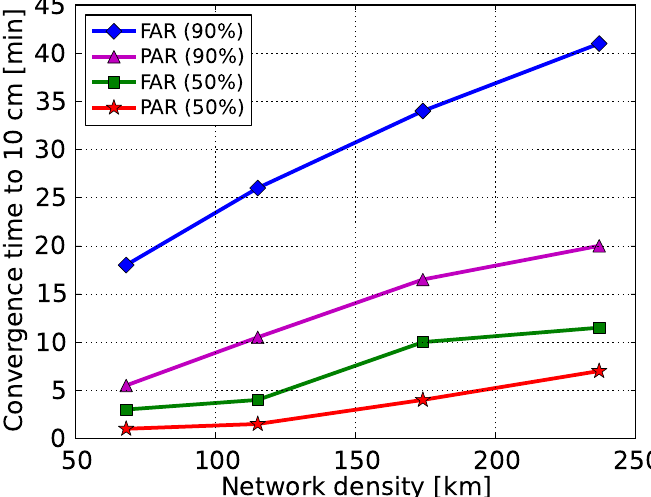
Figure 9. Convergence time of the horizontal radial position errors to 10 cm as a function of the network density for both FAR and PAR, based on 50% and 90% of the sample